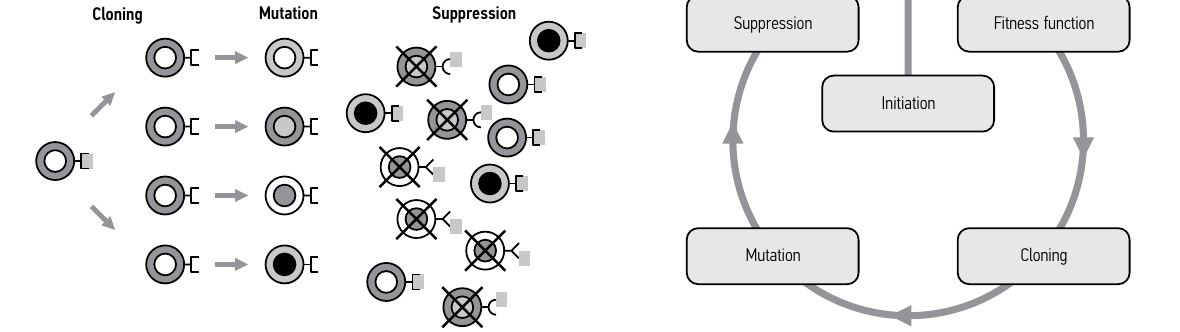
Fig. 2. The process of clonal selection Fig. 3. The steps of artificial clonal